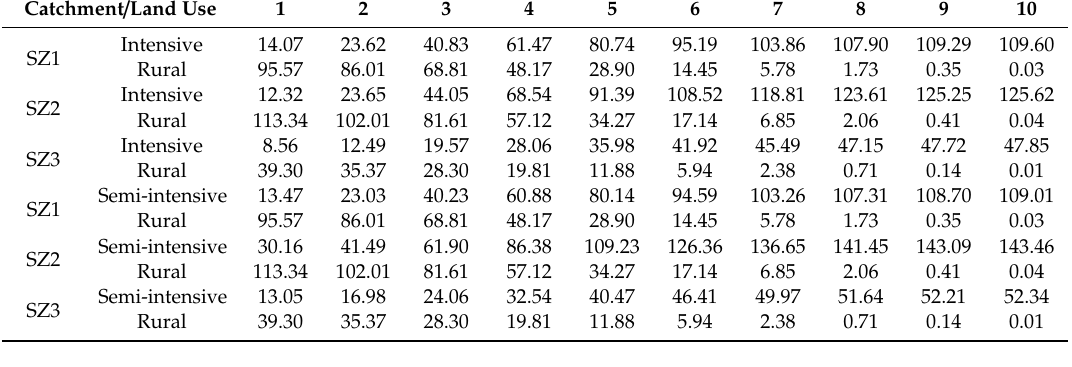
Table 11. Scenarios for analyzing the sensitivity of optimal SUDs combinations. Areas of land use by catchments (10 6 m 2 ).